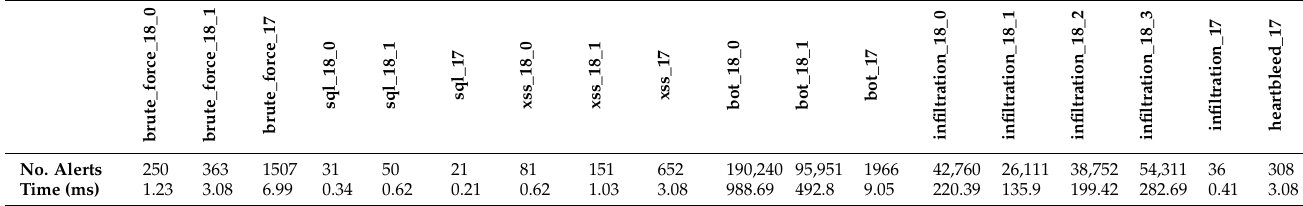
Table 7. The average processing time to generate sig attr for a selection of attack scenarios of CICIDS2017 and CSE-CIC-